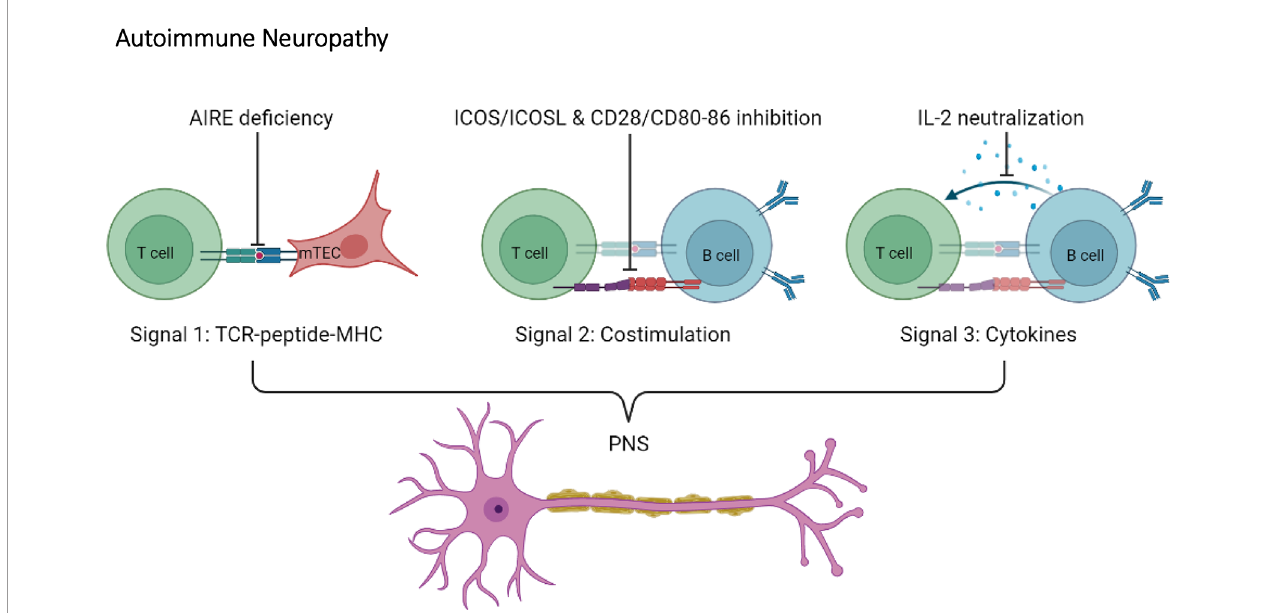
FIGURE 4 | Disruption of T cell activation signals induce autoimmune neuropathy in the NOD mouse. Autoimmune neuropathy can be induced in the NOD mouse after modulation of one of the three T cell activation signals. More speci fi cally, mutations in AIRE transcription factor expression in medullary thymic epithelial cells (mTECs) indirectly impact signal 1. In addition, disruptions in co-stimulation signals, such as ICOS/ICOSL and CD28/CD80-86 (signal 2), or neutralization of IL-2 (signal 3) induce autoimmune neuropathy in the NOD